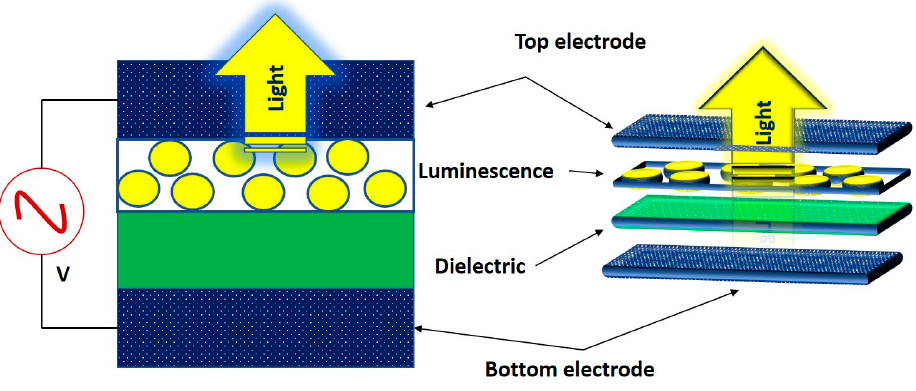
Figure 2. Basic structure of electroluminescence device.